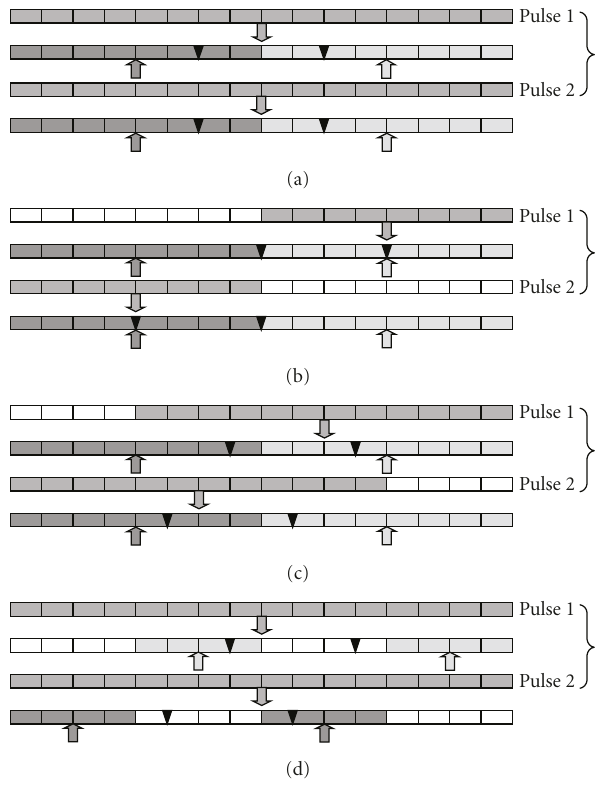
Figure 1: RADARSAT-2 MODEX modes: (a) standard two- channel receive mode, (b) three-channel half-aperture toggle- transmit mode, (c) four-channel 3/4-aperture toggle-transmit mode, and (d) four-channel quarter-aperture toggle-receive mode. Shaded rectangles constitute active antenna panels with di ff erent shades representing di ff erent channels; down/up arrows represent transmitter/receiver physical center positions, respectively; black down-pointing triangles denote two-way e ff ective phase